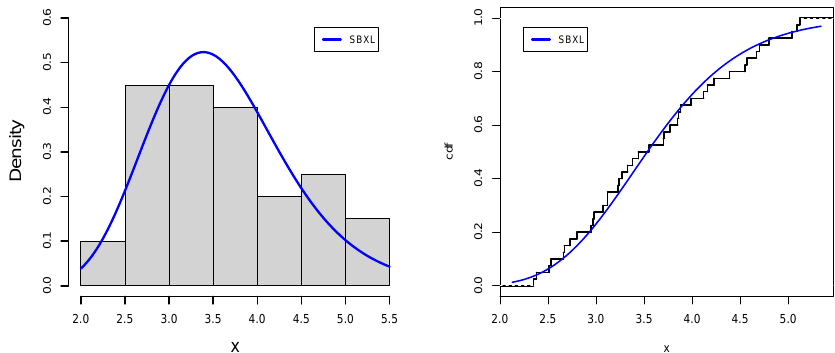
Figure 7. Plots of estimated pdf and cdf of the SBXL model for data set-I.